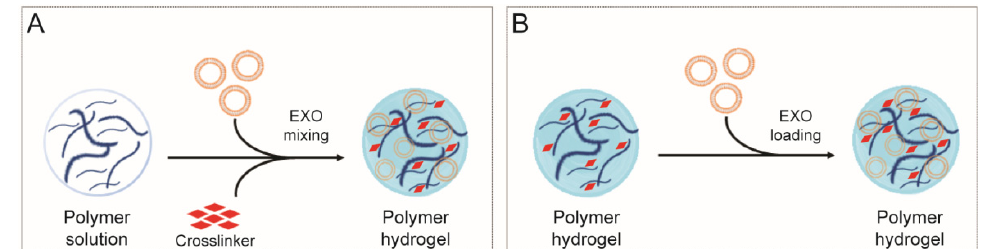
Figure 5. Entrapment of EXOs into polysaccharide-based matrices. In panel ( A ), the EXOs are mixed into a polymeric solution, then gelled by the addition of a cross-linking agent [128–140]; in panel ( B ), the EXOs are directly loaded in a pre-formed gel [141–147].